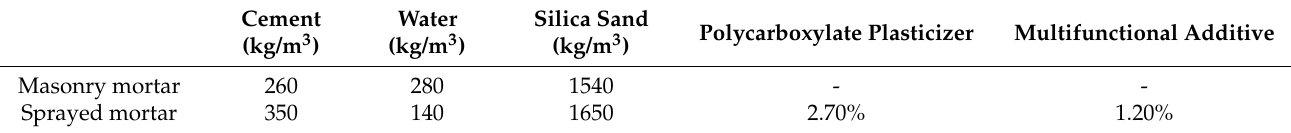
Table 1. Mixture